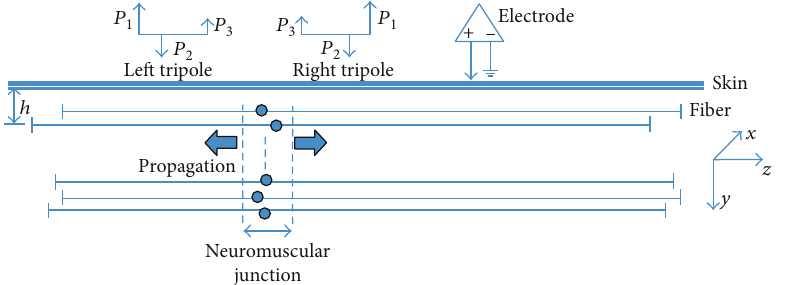
Figure 2: The simulated muscle fi ber action potential generation and the detection system. All the muscle fi bers are uniformly distributed in a cylinder at di ff erent depths h ( y axis). The left or right current tripole originates from the neuromuscular junction and propagates along the direction of z axis, to the fi ber-tendon termination.